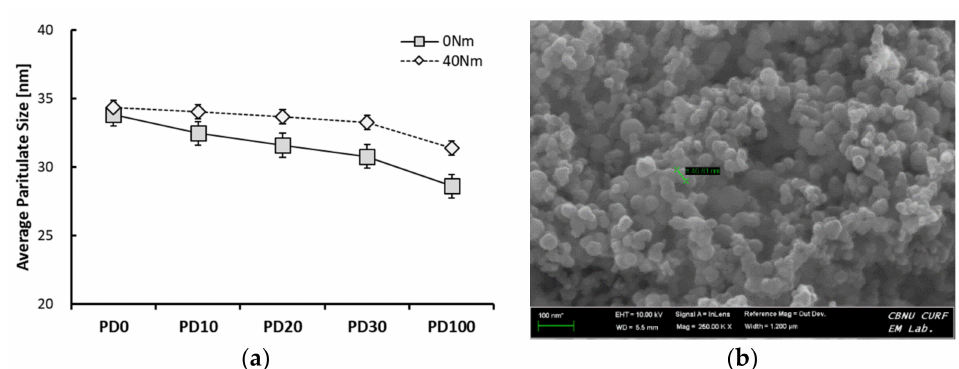
Figure 11. Average particulate size by engine loads: ( a ) average particulate size and ( b ) particulate size measurements.